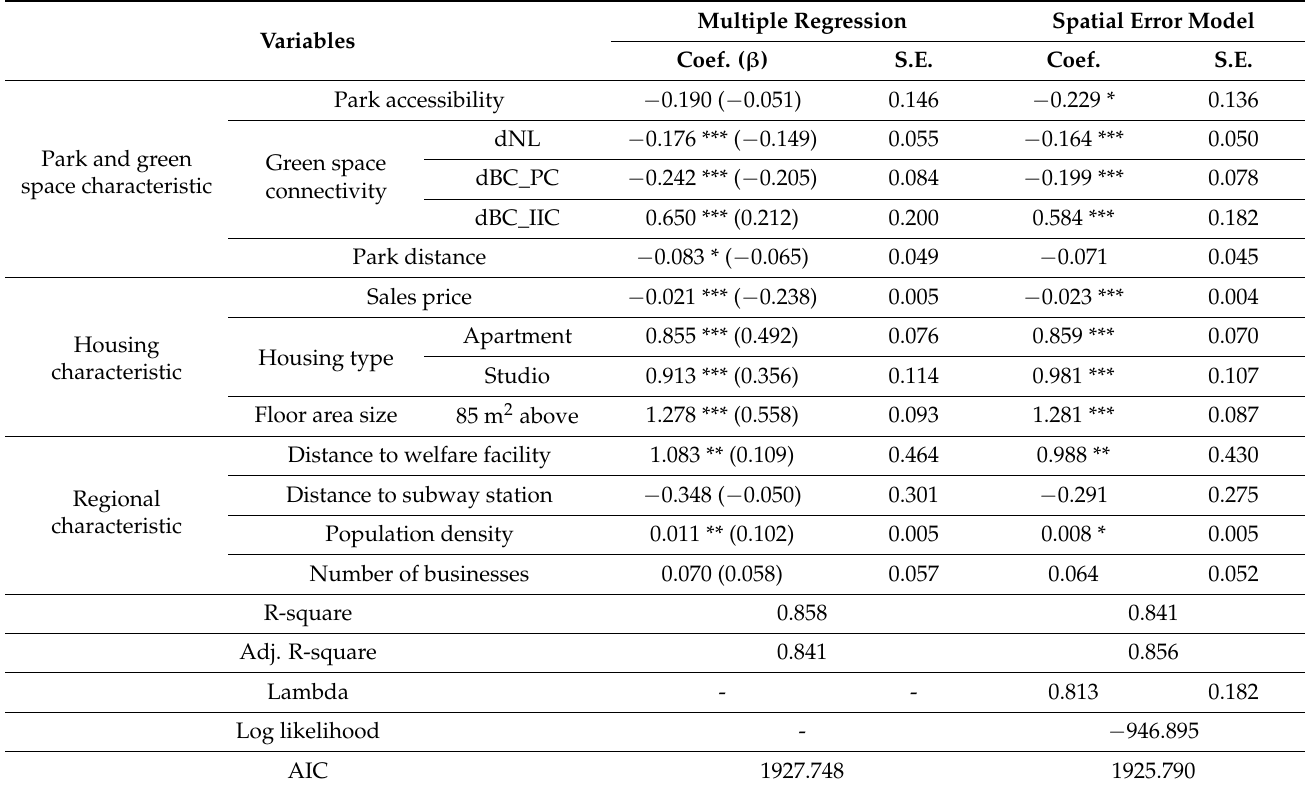
Table 3. Regression Results for the Total Single-person